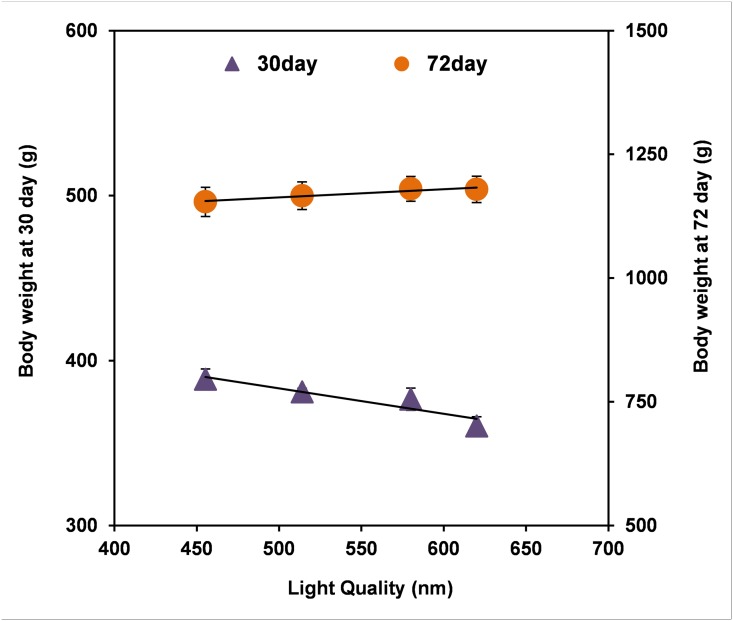
The linear regression of live body weights of broilers on light quality. Broilers were exposed to wavelengths from 455 to 620 nm, either to RL (red LED), YL (yellow LED), GL (green LED) or BL (blue LED).Live body weights at an early age (30 days; triangle) and later age (72 days; circle) showed a linear relationship with light wavelength. Live body weight (30 days) = -0.154 × wavelength + 460.1 (R
2 = 0.8755), live body weight (72 days) = 0.164 × wavelength + 1081.2 (R
2 = 0.9251). Data are expressed as means ± SEMs (n = 4). Bars marked with different letters are significantly different from each other (P < 0.05).